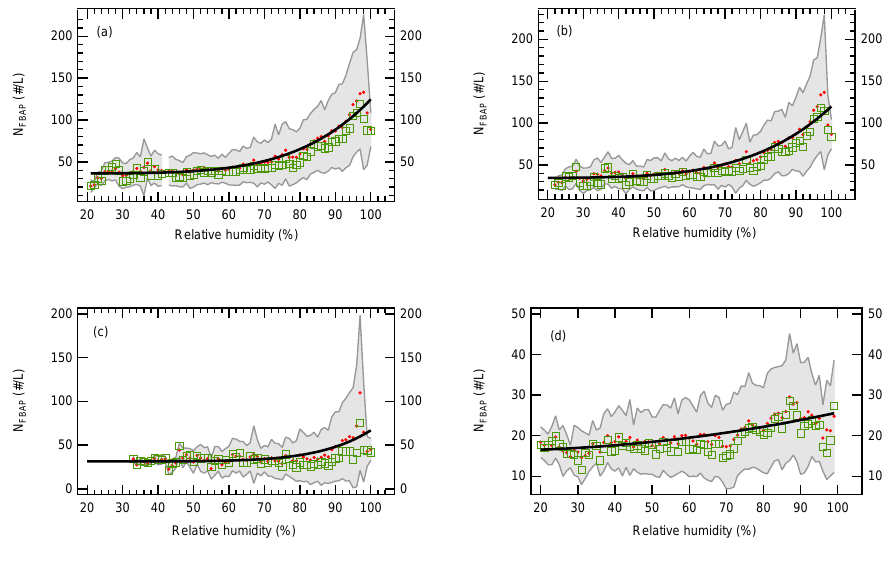
Fig. 16. Correlation of the WIBS-4 FBAP number concentrations with the relative humidity; red markers show mean FBAP concentration ( N FBAP , #/L), green markers show median N FBAP , solid black lines represent fitted curve according to the mean N FBAP , grey shaded areas represent variability of FBAP concentration as plus-minus standard deviations. Fit function: f (x) = a · x b + c ; (a) spring ( R 2 = 0 . 924), (b) summer ( R 2 = 0 . 911), (c) autumn ( R 2 = 0 . 541), (d) winter ( R 2 = 0 .